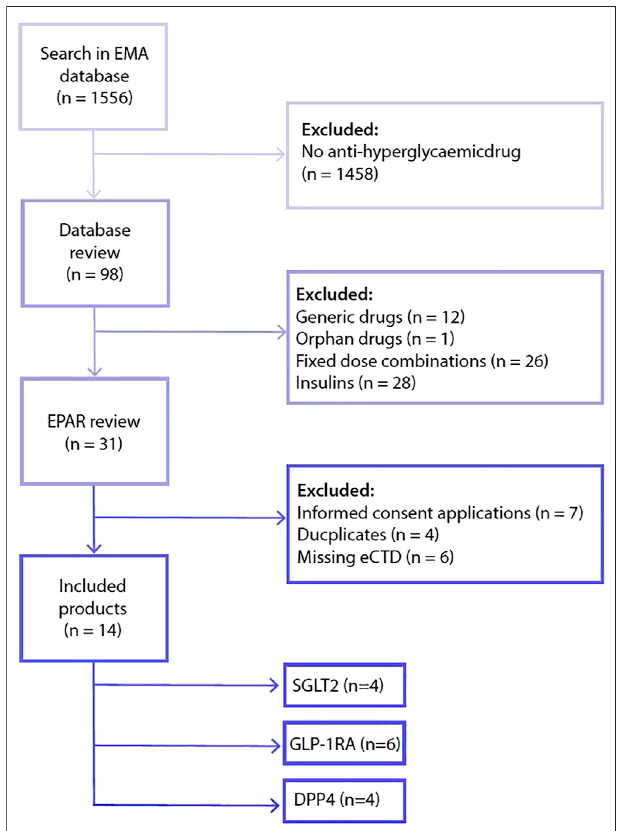
FIGURE 1 | Flowchart included drugs. Abbreviations: dipeptidyl peptidase-4(DPP4),electronicdrugapplicationdossier(eCTD),glucagon-like peptide-1 receptor agonist (GLP-1RA), sodium-glucose co-transporters -2